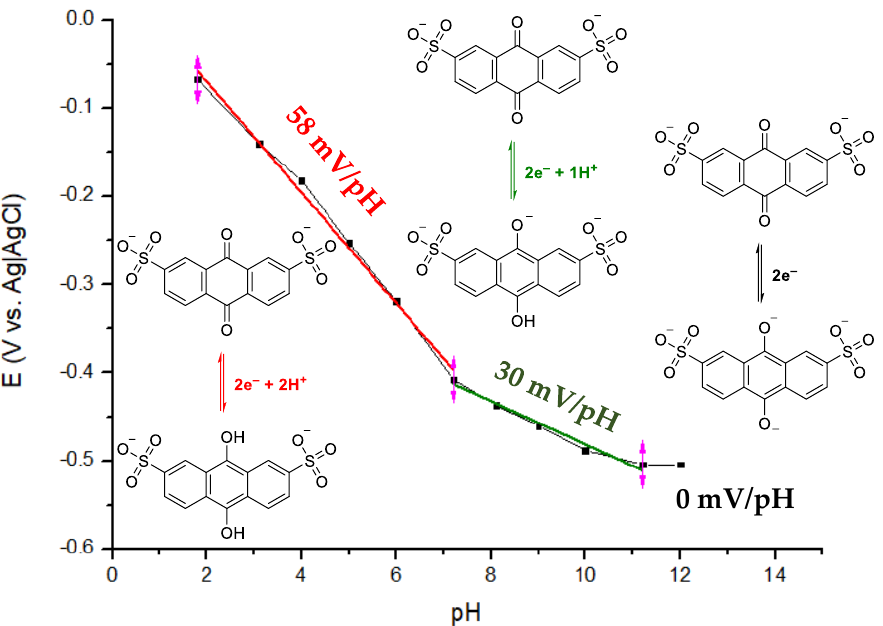
Figure 2. Pourbaix diagram of AQDS evaluated from CV measurements at different pH values on WE: glassy carbon, CE: platinum wire and RE: Ag|AgCl. A total of 10 mM AQDS in 1 M KCl at 5 mV/s was used.